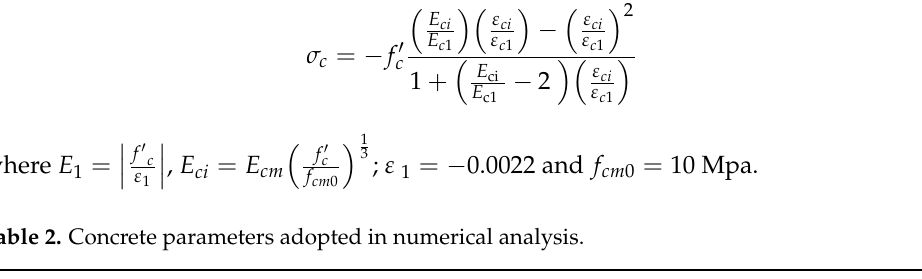
Table 2. Concrete parameters adopted in numerical analysis.